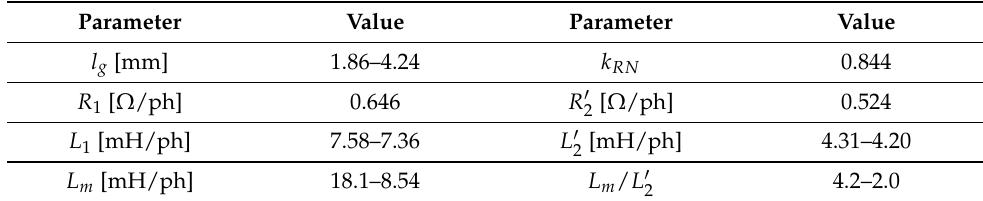
Table 2. Calculated parameters for the prototype.